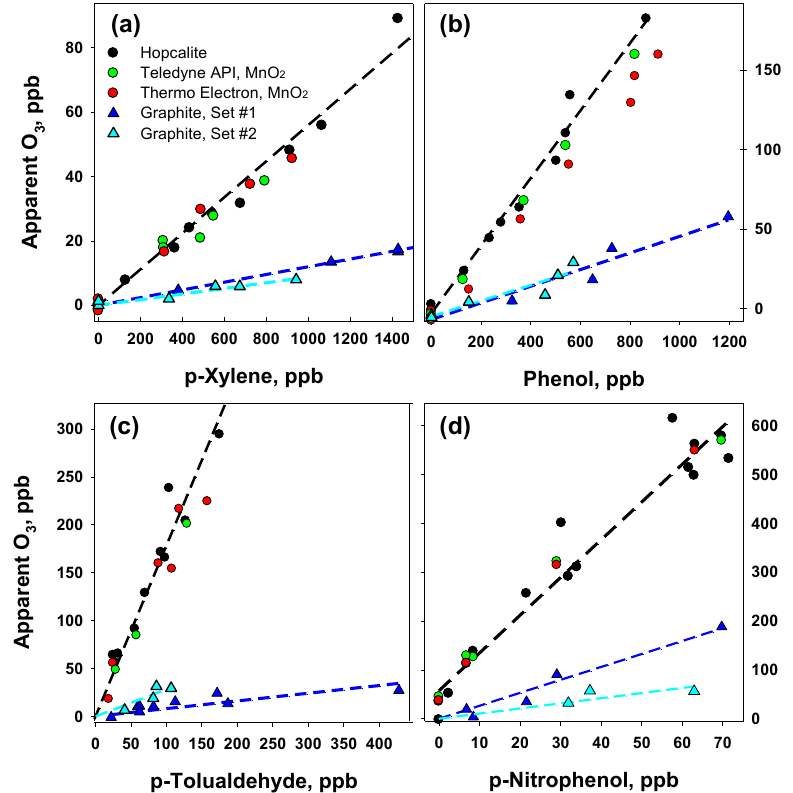
Figure 7. Apparent ozone vs. VOC concentration in dry, ozone-free air for different scrubber types and four different VOCs of varying absorption cross section at 253.7nm. Data from two different sets of graphite tubes are shown (Set #1 and Set #2). Slopes are given in Table